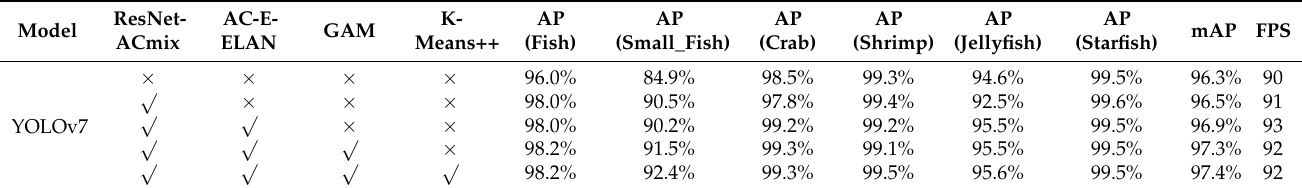
Table 7. Ablation comparison of model performance improvement on the Brackish dataset.